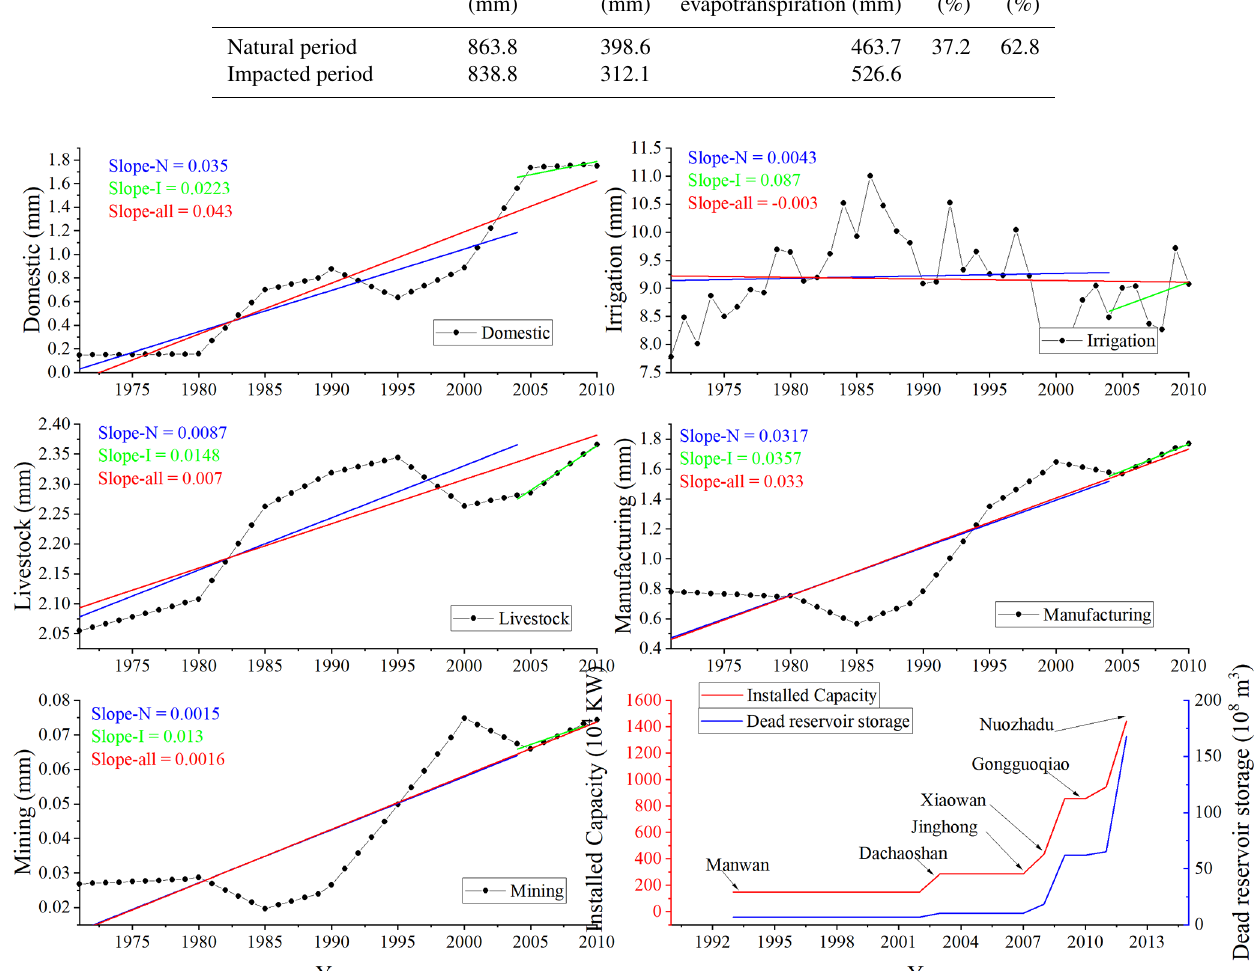
Figure 13. Annual water withdrawals of the LR basin during the period from 1970 to 2010. The linear trend lines are indicated by blue (1970–2004), green (2005–2010), and red (1970–2010), and in the last panel, the total dead storage capacity and installed capacity of the LR from 1992 to 2012 are